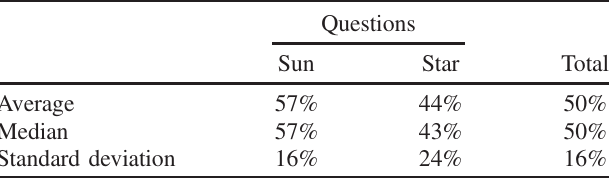
TABLE IV. Test results of university students ( n ¼ 48 ).